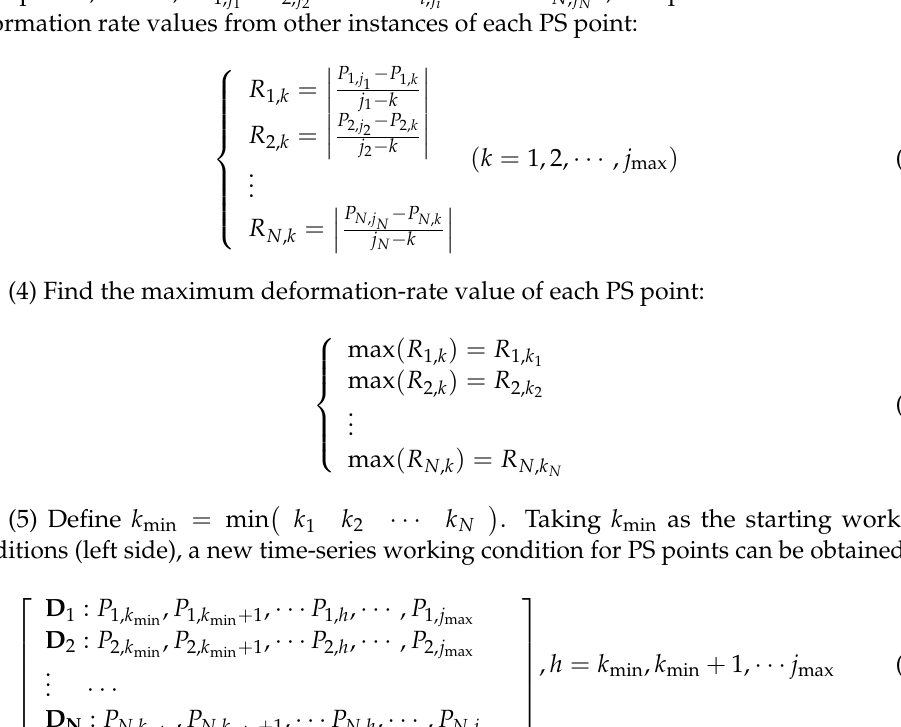
Figure 4. Process used to decide